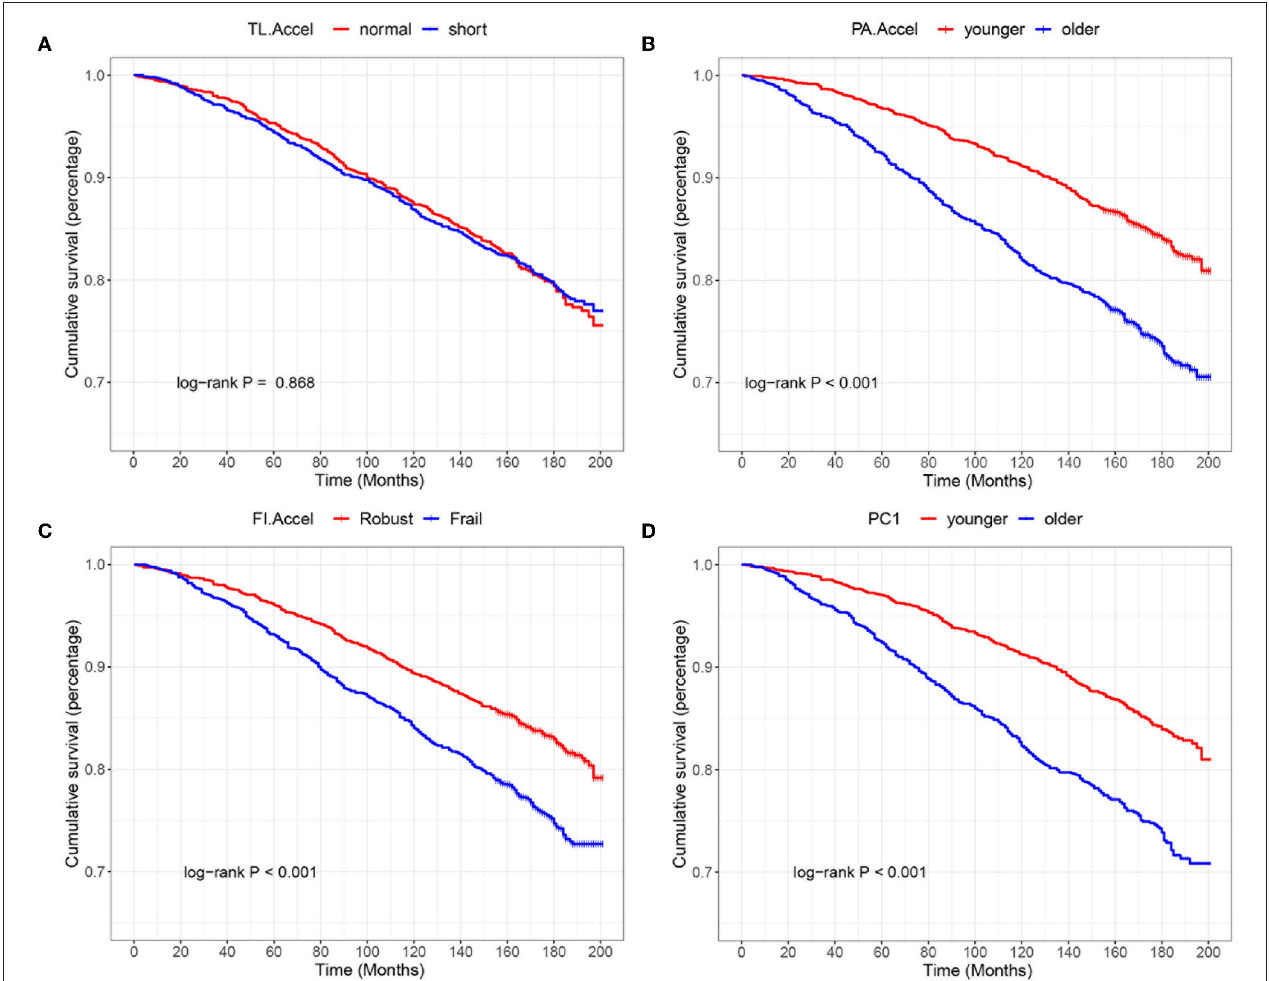
FIGURE 2 | K-M curves of different aging measures for predicting all-cause mortality. TL.Accel, PA.Accel and FI.Accel represent residuals from linear models when regressing telomere length, Phenotypic age, and frailty index on chronological age, respectively. PC1 is the first principal component of PA.Accel and FI.Accel through the principal component analysis. (A–D) represent K-M curves of TL.Accel, PA.Accel, FI.Accel and PC1 for predicting all-cause mortality, respectively. HEI-2010 of the three tertiles group were 31.5, 45.7, and 62.3,